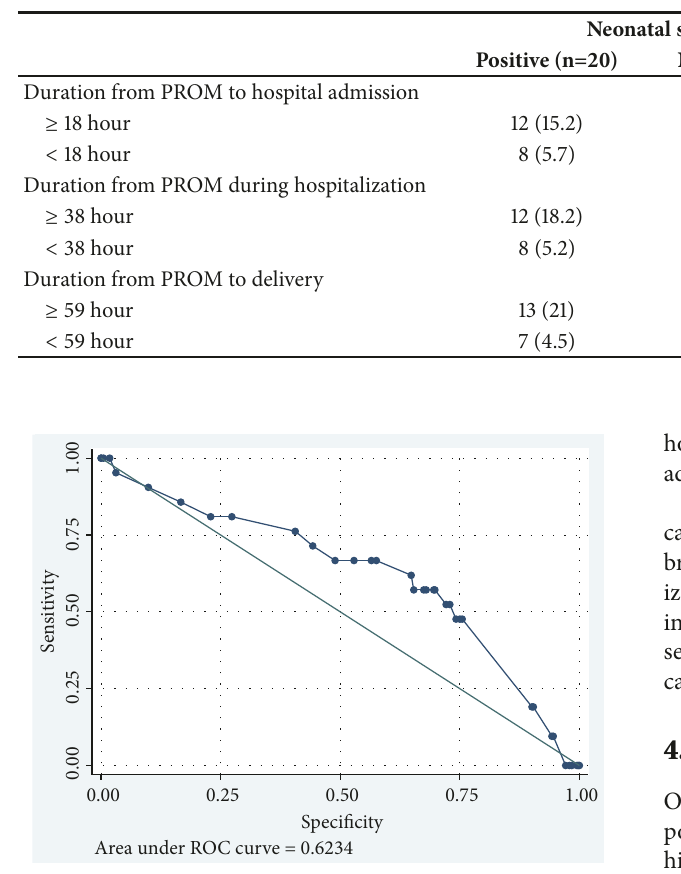
Figure 2: ROC curve duration from PROM to hospital admission in all PROM